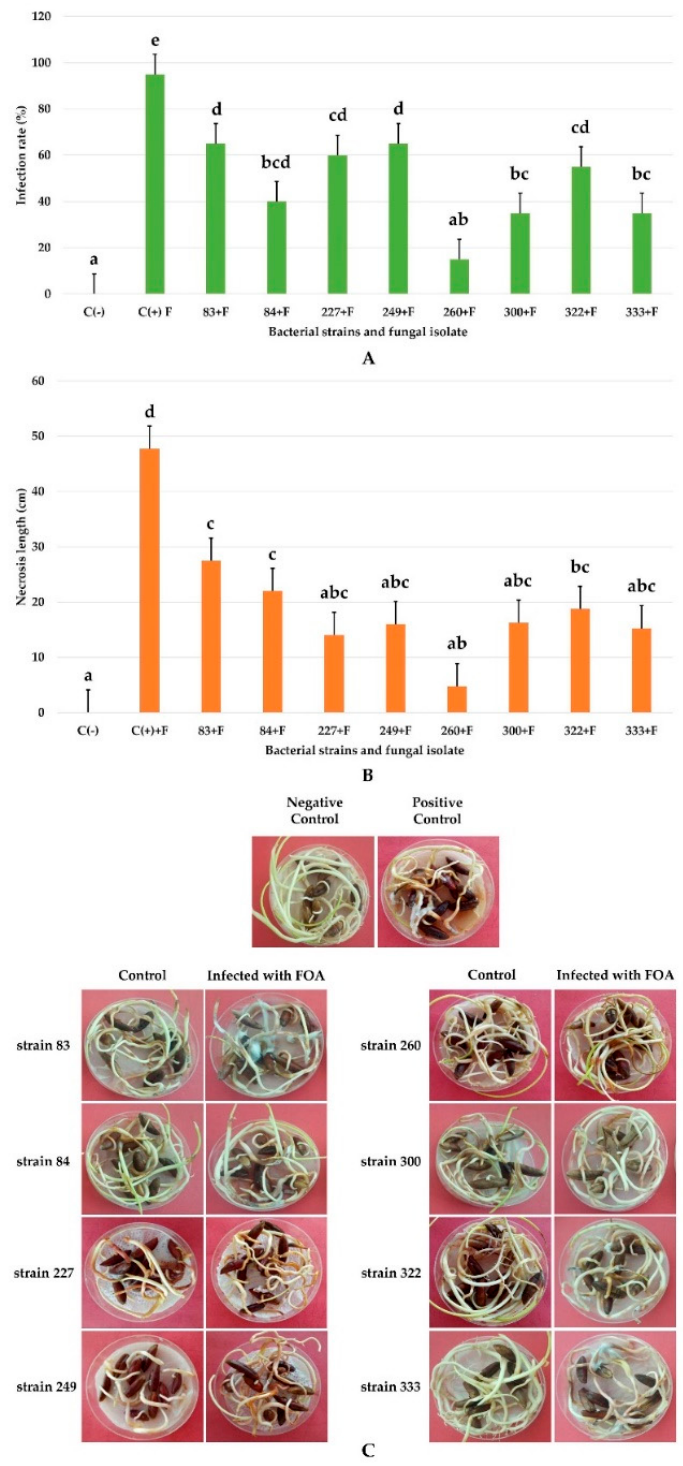
Figure 9. ( A ) Infection rate, ( B ) Size of root necrosis of germinated date palm seeds. The data present the means ± the standard error. Different letters between bars in each group indicate a significant difference at ( p < 0.05) determined by ANOVA with the comparison of means using Tukey’s HSD. ( C ) In vivo biocontrol test of date palm seeds infected with FOA and treated at the same time with the different bacterial strains. The seeds considered as negative and positive controls are represented